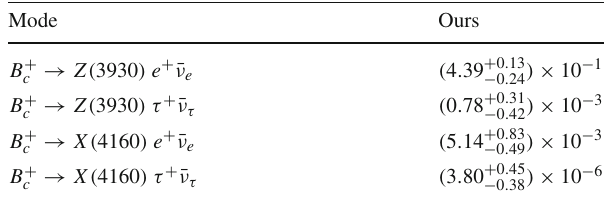
Table 1 The decay widths of exclusive semileptonic decays of B c to Z ( 3930 ), X ( 4160 ) (in 10 − 15 GeV)